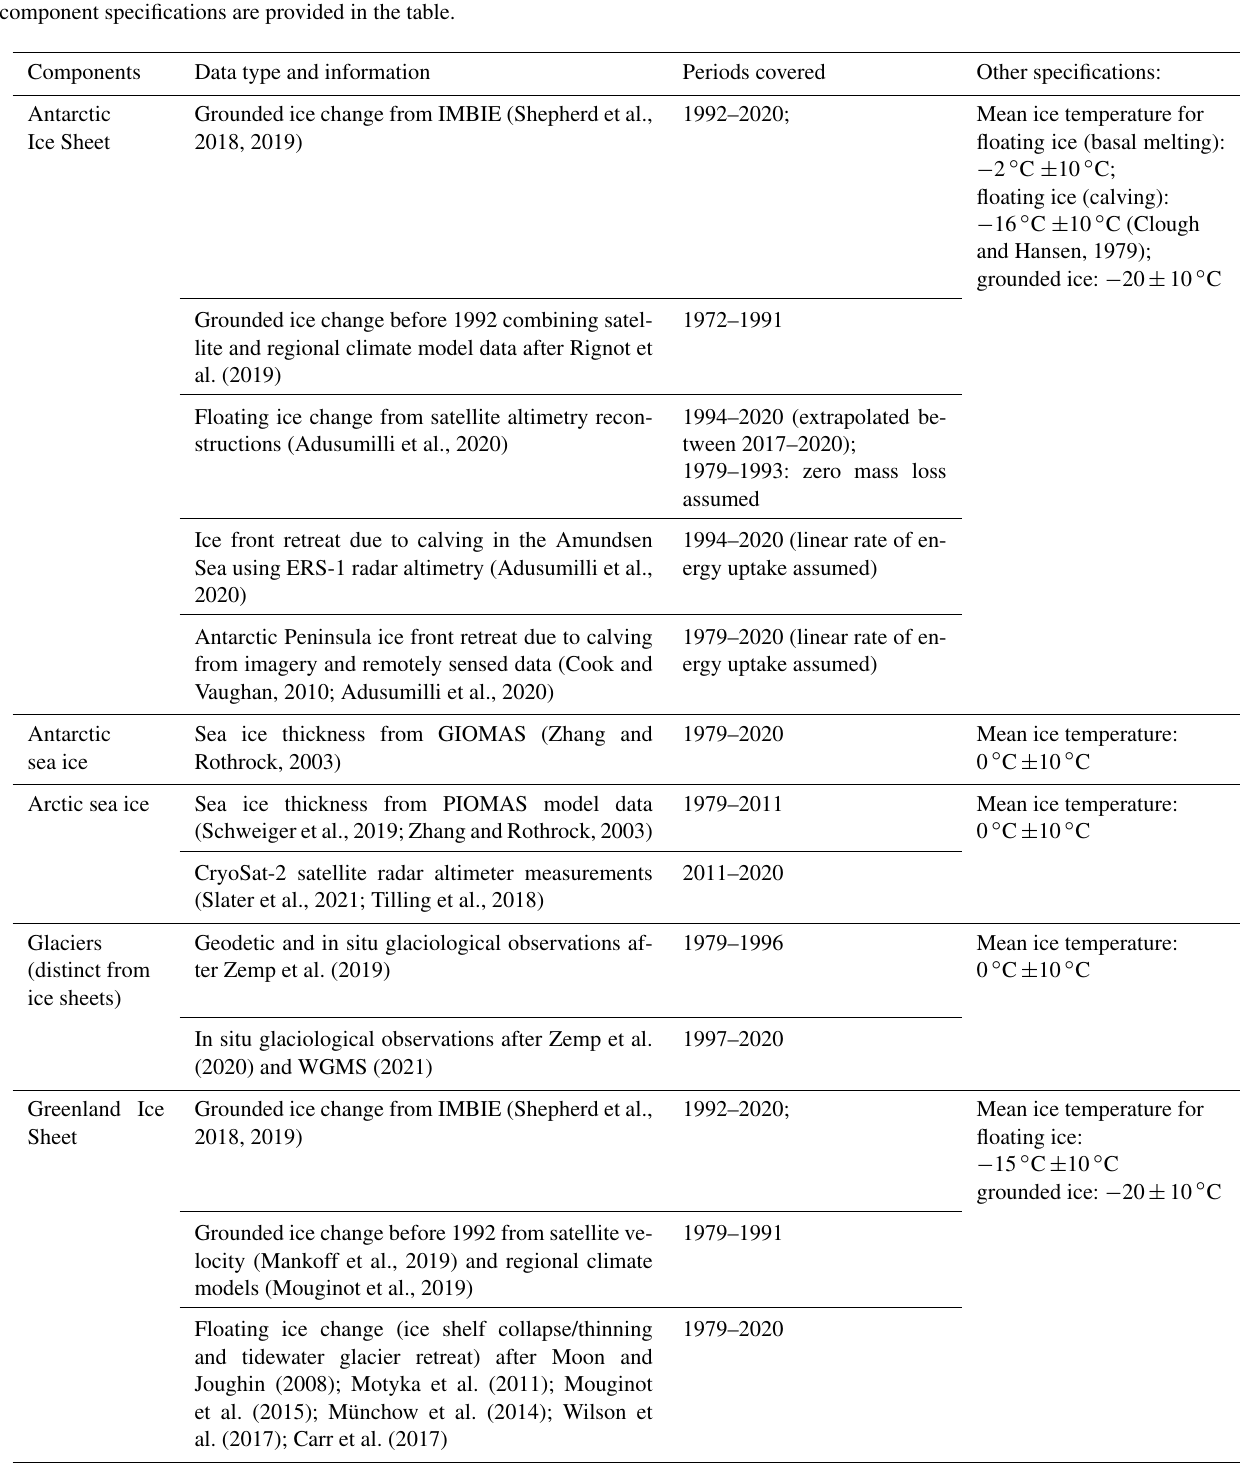
Table 3. Overview on data used and their availability for the estimate of heat available to melt the cryosphere over the period 1979–2020. Backward extension to 1971 for the heat inventory is based on the assumption of negligible contribution. General specifications include constant values for latent heat of fusion of 3 . 34 × 10 5 Jkg − 1 , specific heat capacity of 2 . 01 × 10 3 Jkg − 1 ◦ C − 1 , density of ice of 917kgm − 3 for first-year ice and 882kgm − 3 for multiyear ice; see also Ciais et al. (2014), Slater et al. (2021), and von Schuckmann et al. (2020). Other component specifications are provided in the